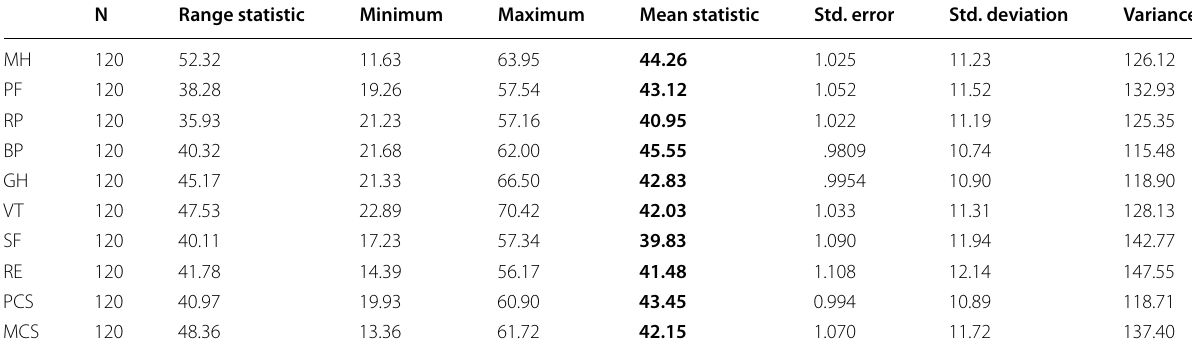
Calculated based on norm-based scores using Optum SF-36V2v2 software [32] PF physical function, RP role physical, BP bodily pain, GH general health, VT vitality, SF social function, RE role emotional, MH mental health, PCS physical composite score, MCS mental health component